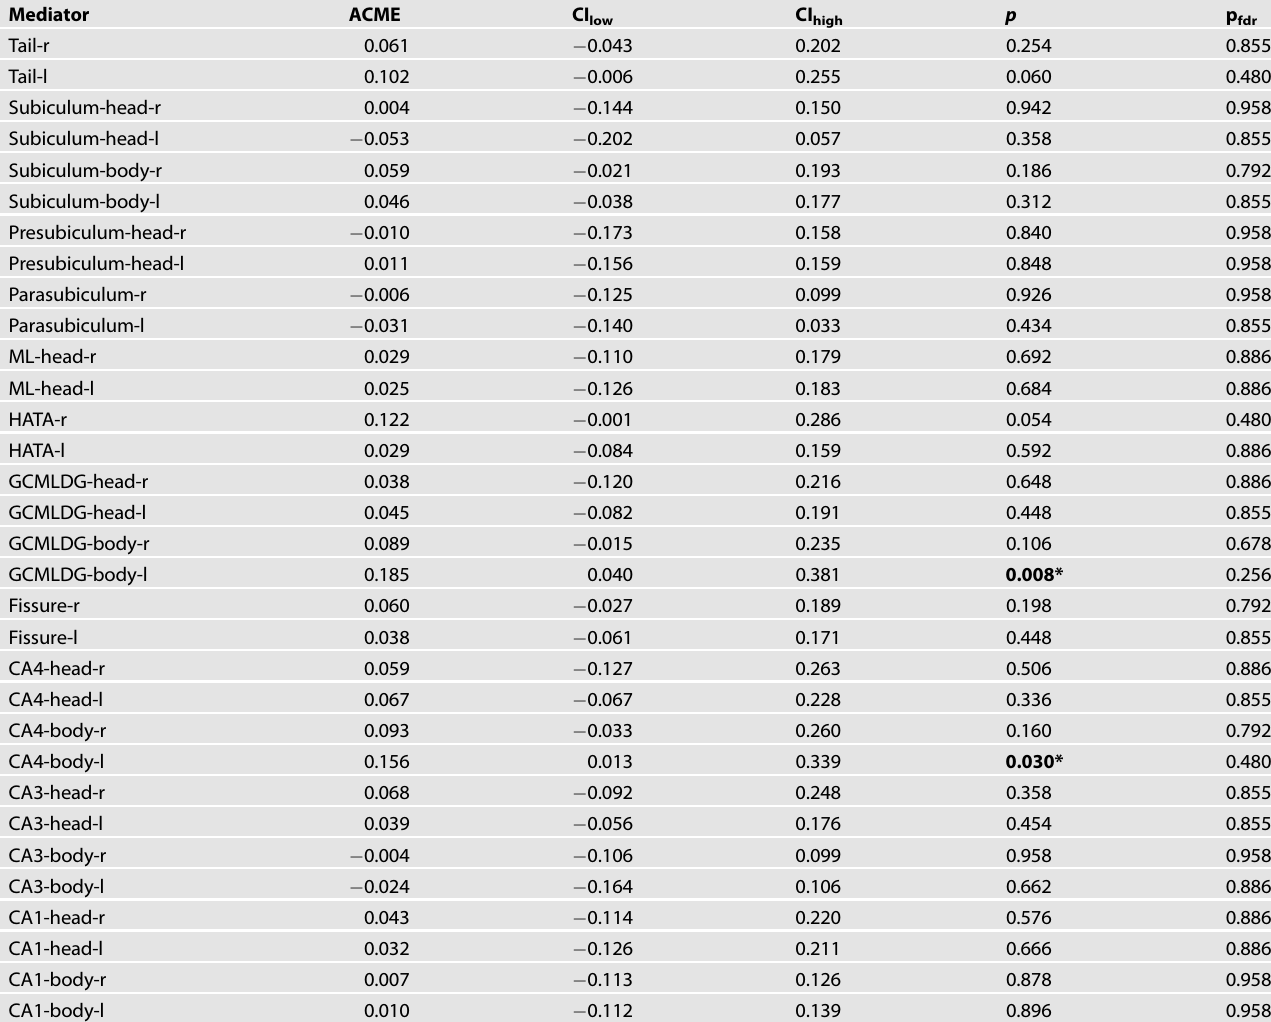
Table. 5. Mediation between aerobic fi tness, hippocampal formation sub fi eld volumes, and Verbal Learning and Memory Test short-term memory